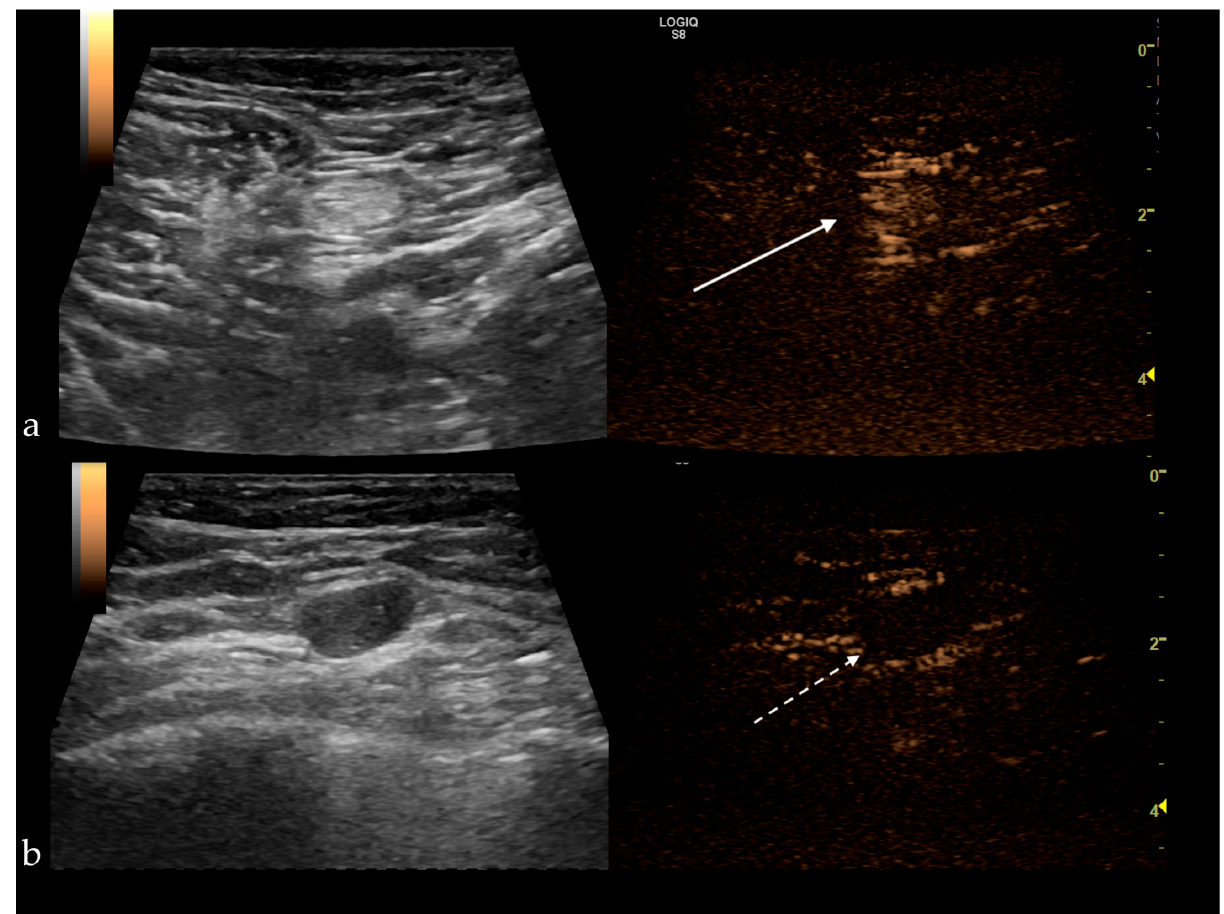
Figure 4. ( a ) Benign sentinel lymph node presenting a homogenous central enhancement (white arrow); ( b ) Metastatic sentinel lymph node with no enhancement after subcutaneous administration of the contrast agent (white dotted arrow). The use of CEUS in SLN assessment after NAC administration is reliable, but is not generally accepted. The detection rate of SLNs before NAC is 99.1% and decreases to